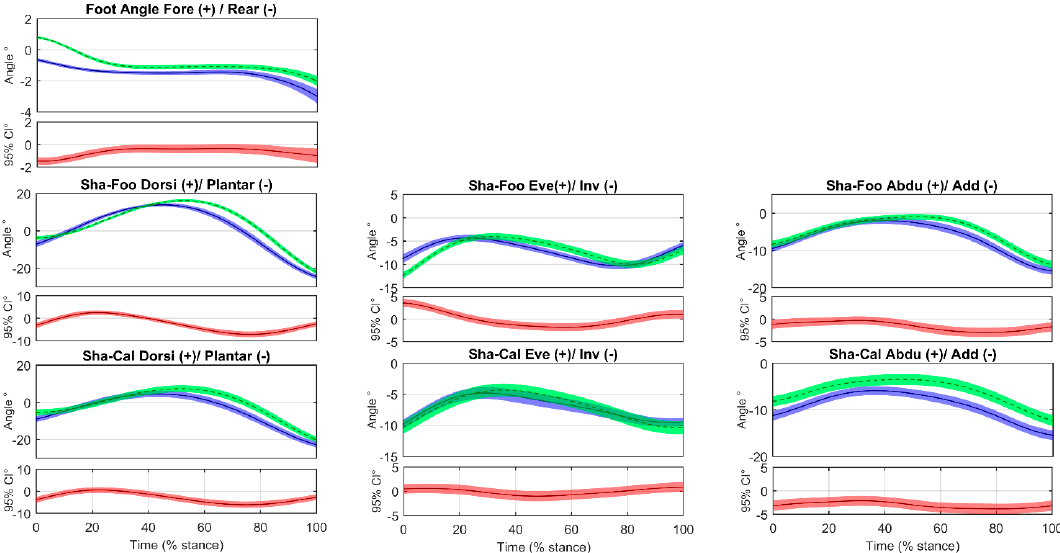
Figure 4. Foot angle with respect to the shank (Sha ‐ Foo) and calcaneus with respect to the shank (Sha ‐ Cal) joint angles time normalized across stance phase (0–100%) for forefoot strike (FFS) and rearfoot strike (RFS) patterns. Mean ± standard error (SE) bands are reported (shaded regions). Below of each angle plot, there is a between footstrike pattern difference plot (FFS–RFS) containing the mean ± 95% confidence interval (CI) bands (in red). Regions where those bands diverge from 0 can be considered regions of significant differences. (Legend: FFS in blue, RFS in green).